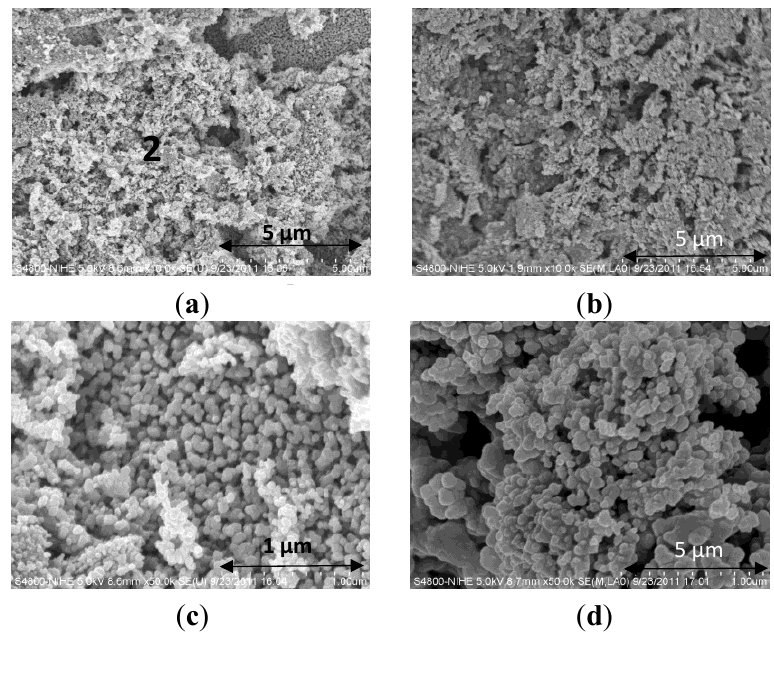
Figure 7. SEM images of final catalysts: Ca.2 (MnO Ca.3 ( a ) Ca.3 at magnification 10000×; ( b ) Ca.2 at magnification 1000×; ( c ) Ca.3, region 2 at magnification 50000×; ( d ) Ca.2 at magnification